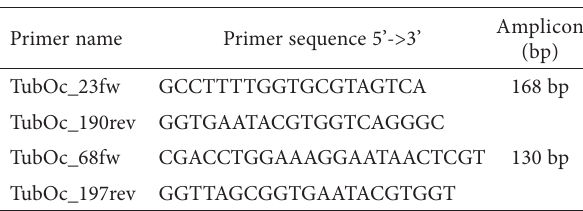
Table 2. Sequences of the primers designed for the specific detec- tion of Colletotrichum ocimi